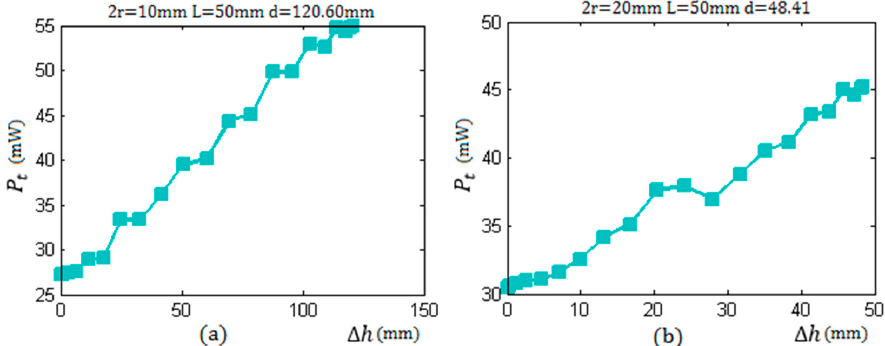
Figure 9. The change law of the actual total energy P t received by the sensor with the increase of ∆ h from 0 to d with the thickness of a container wall being 50 mm: ( a ) the sensor radius r = 5 mm; and ( b ) the sensor radius r = 10 mm.